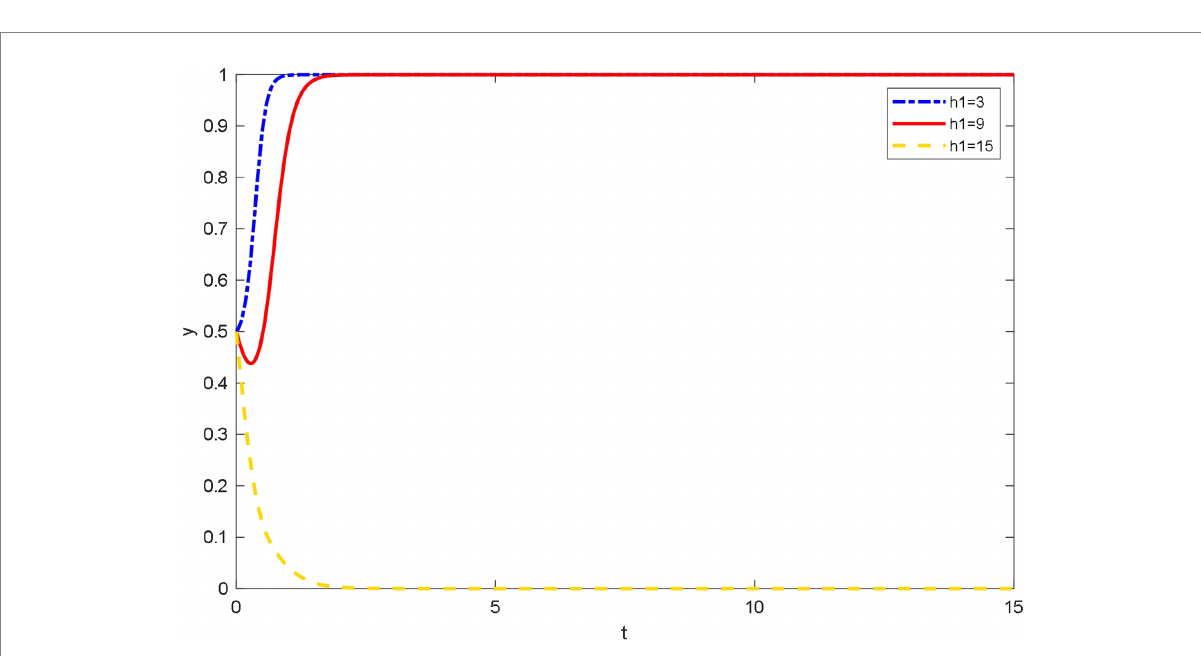
FIGURE 8 Evolutionary trajectory of patient’s strategy selection under different online healthcare